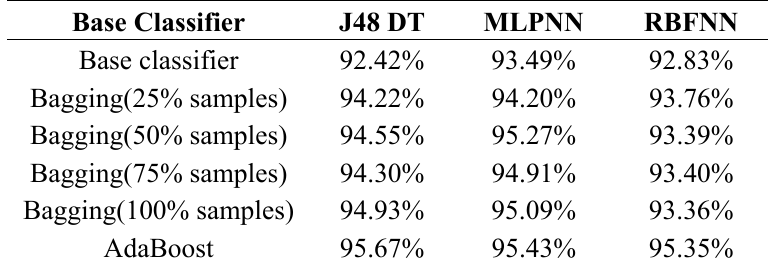
Table 1. Accuracy of Bagging and AdaBoost using different base